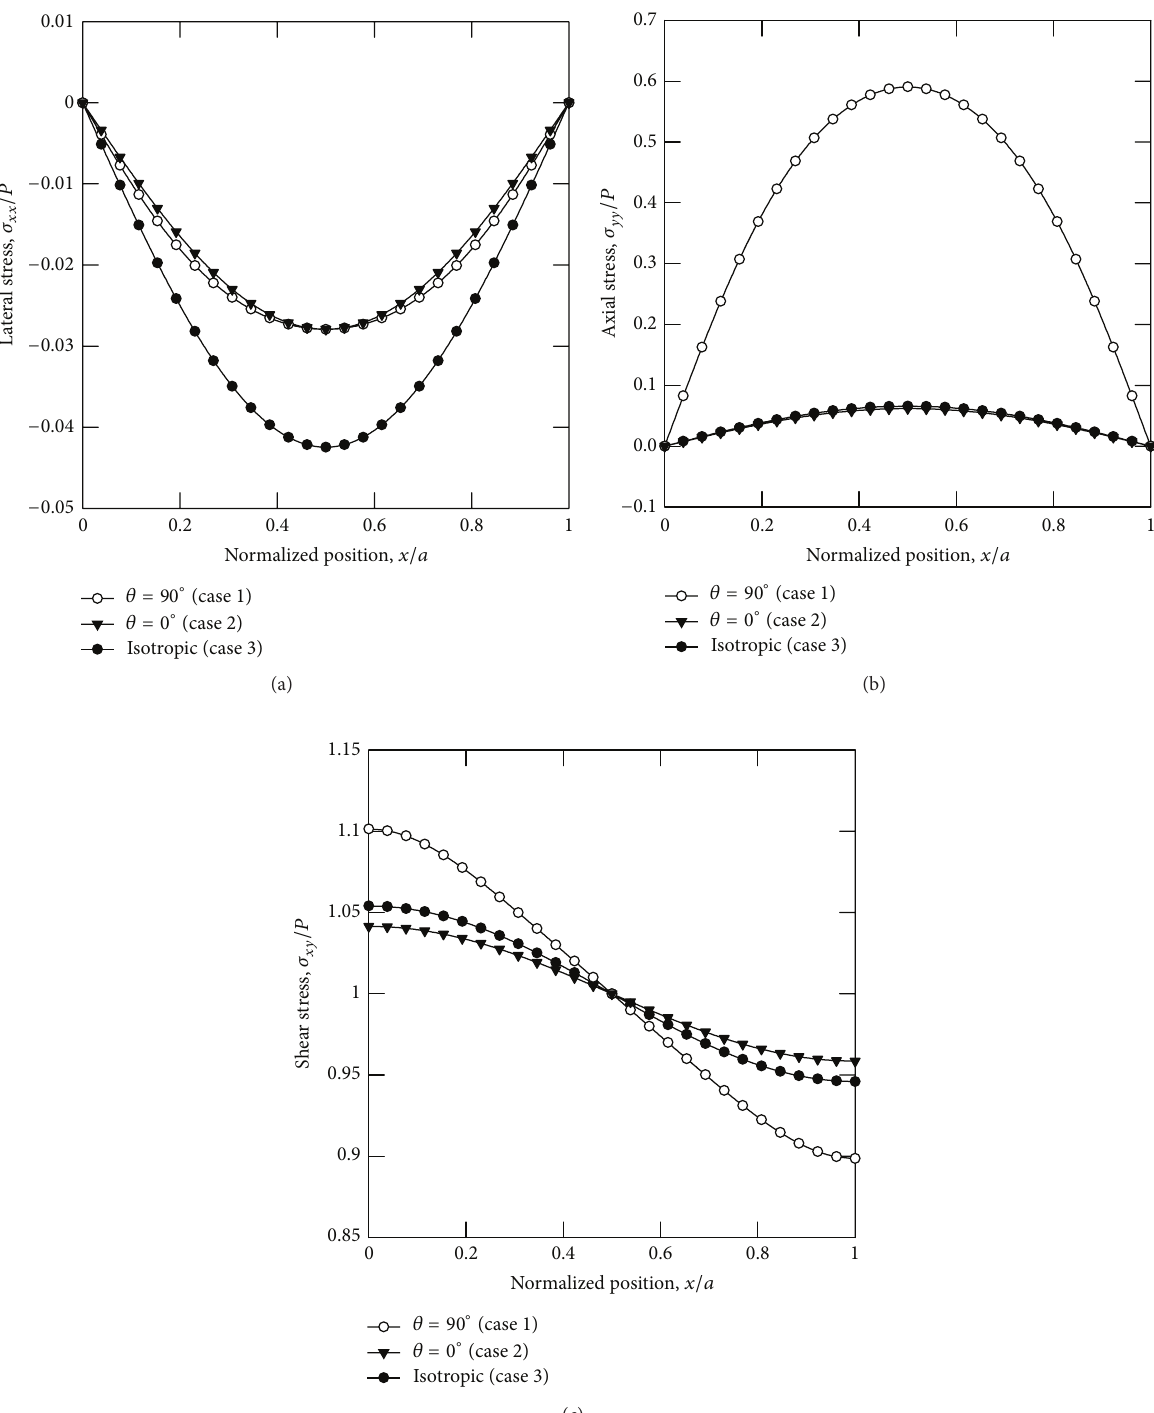
Figure 6: Effect of fiber orientation and material isotropy on the normalized stress components at the section 𝑦/𝑏 = 0.5 of the panel: (a) lateral stress component; (b) axial stress component; (c) shear stress